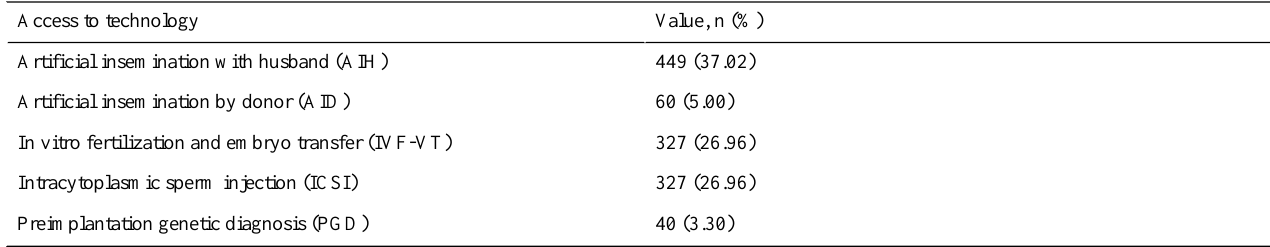
Table 3. The number of accessible technologies (total is the sum of all access technology).